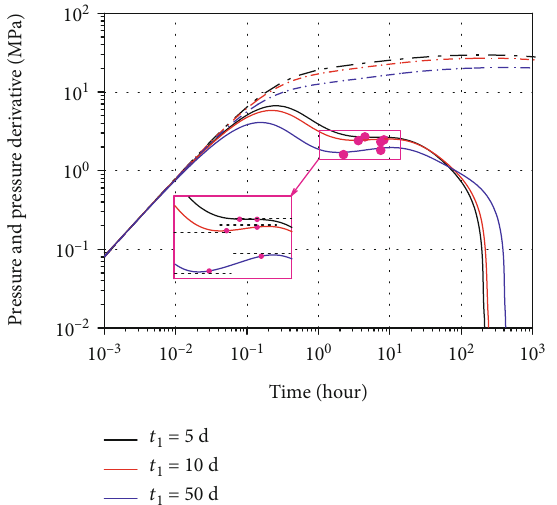
Figure 11: E ff ect of injection time on pressure transient response. t is the injection time of testing well. Figure